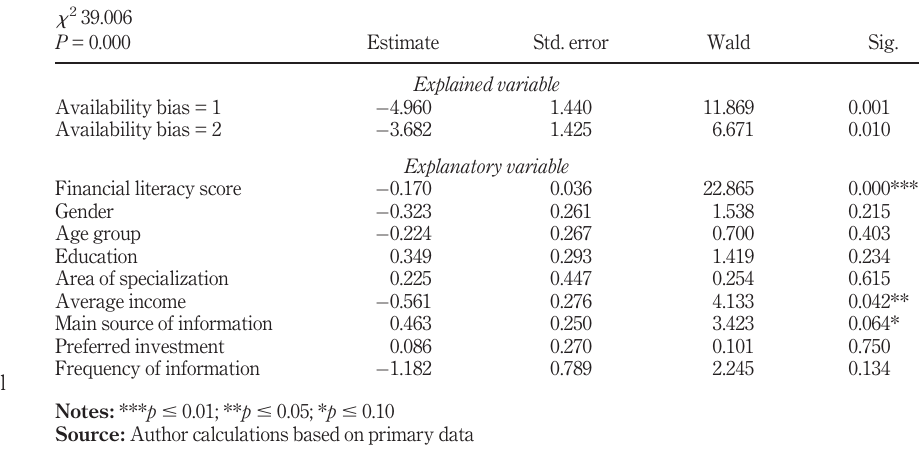
Table 10. Results of ordinal regression for availability